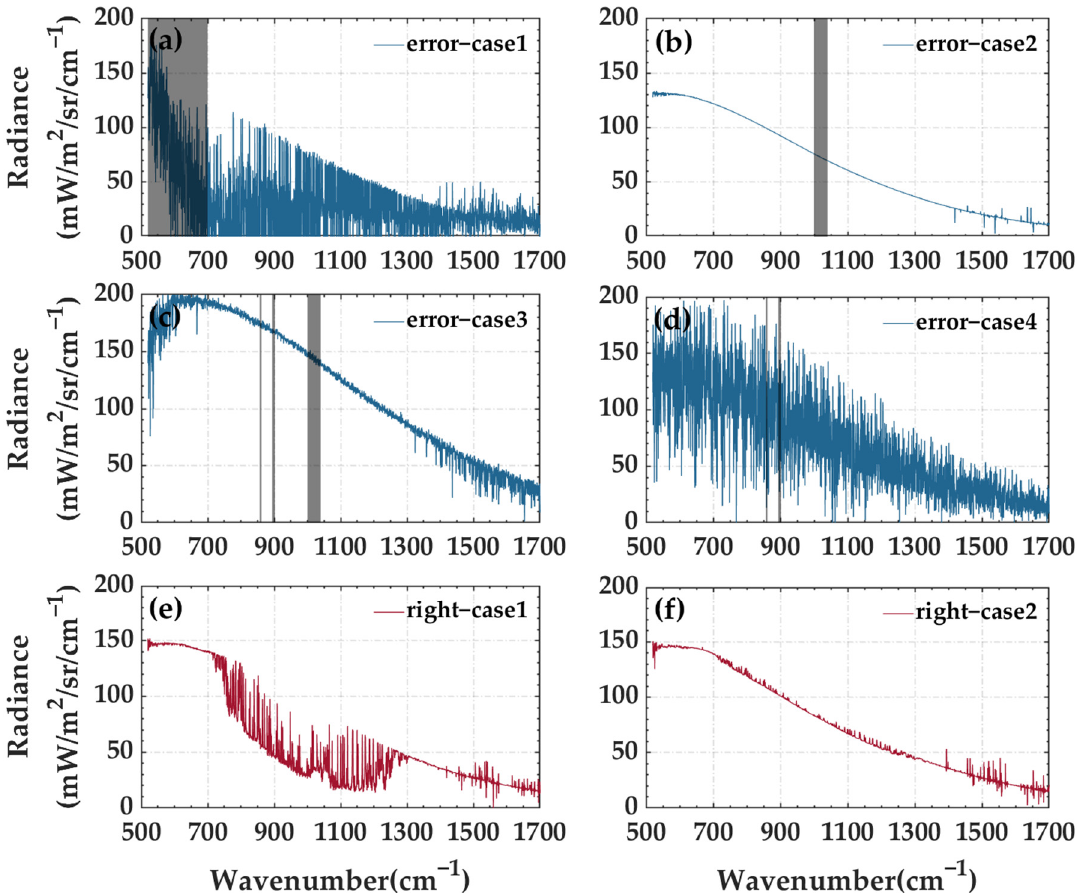
Figure 1. Blue lines indicate the obvious outliers of AERI ( a – d ). Gray background parts represent the corresponding features in Table 1. Error-case1 can be found based on feature 5, error-case2 can be found based on feature 1 and feature 2, error-case3 can be found based on feature 1-4, and error-case4 can be found based on feature 3 and feature 4. Red lines show two typical ideal examples without noise ( e , f ). Table 1. Spectral features of obvious outliers corresponding to gray background parts in Figure 1.